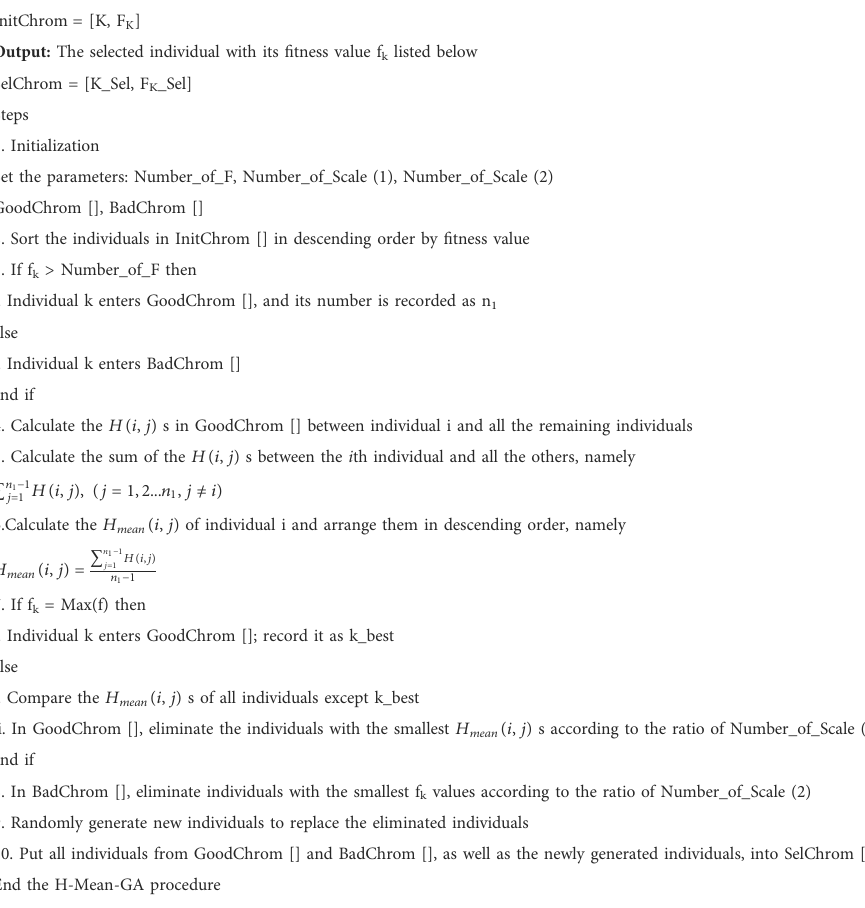
TABLE 1 Pseudocode of utilizing the H-Mean metric for selection.